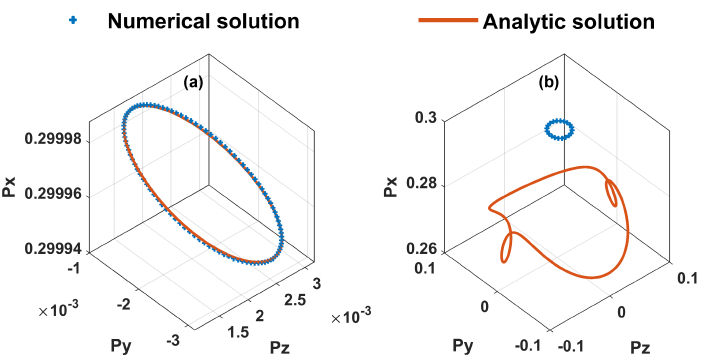
Figure 2. Comparison between the analytic and numerical results of the dynamic of the atomic polarization vector within the period of ten complete cycles under ( a ) weak modulation ( f x = 20 Hz, f y = 10 Hz, f z = 10 Hz, B m x = 1 nT, B m y = 0.5 nT, B m z = 0.5 nT) and ( b ) strong modulation ( f x = 2 kHz, f y = 1 kHz, f z = 1 kHz, B m x = 100 nT, B m y = 50 nT, B m z = 50 nT). Blue and red curves represent the numerical result and the analytic result, respectively.